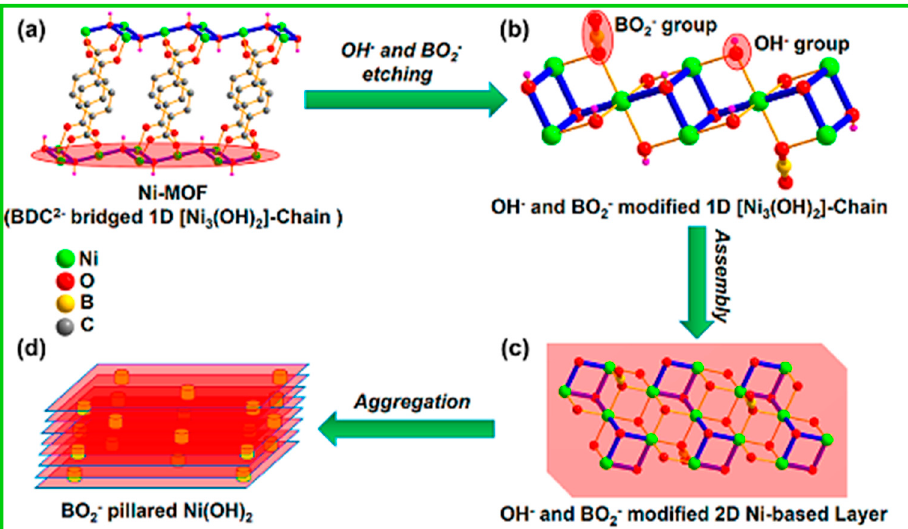
Figure 14. Graphical presentation of the fabrication procedure of the Ni(BO 2 − )-LDH-X. Reprinted with permission from [268], Copyright 2020, American Chemical society.